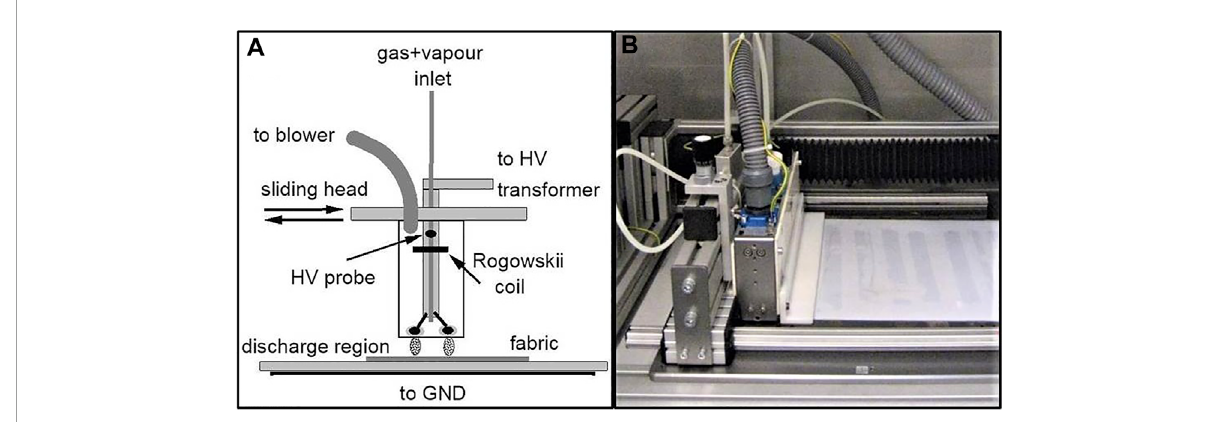
FIGURE 2 A series of SEM images with four increasing magnifications: (A) ×100, (B) ×750, (C) ×1,500, and (D) ×3,000, of the untreated cashmere fabric sample. An approximate vertical orientation of the fibers was chosen at the highest scales.